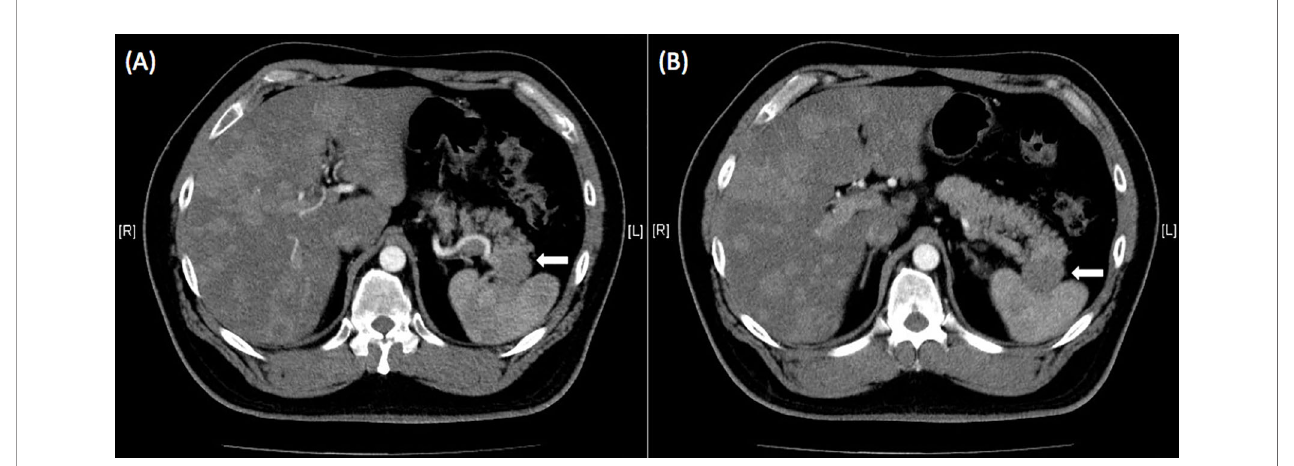
FIGURE 1 | (A) Abdominal computed tomography showed a pancreatic body tumor approximately 1.5 cm in size associated with liver tumors in the right and left lobes. Adrenal glands were normal without enlargement. (B) A suspected tumor at the pancreatic tail was disclosed on enhanced abdominal computed tomography (white